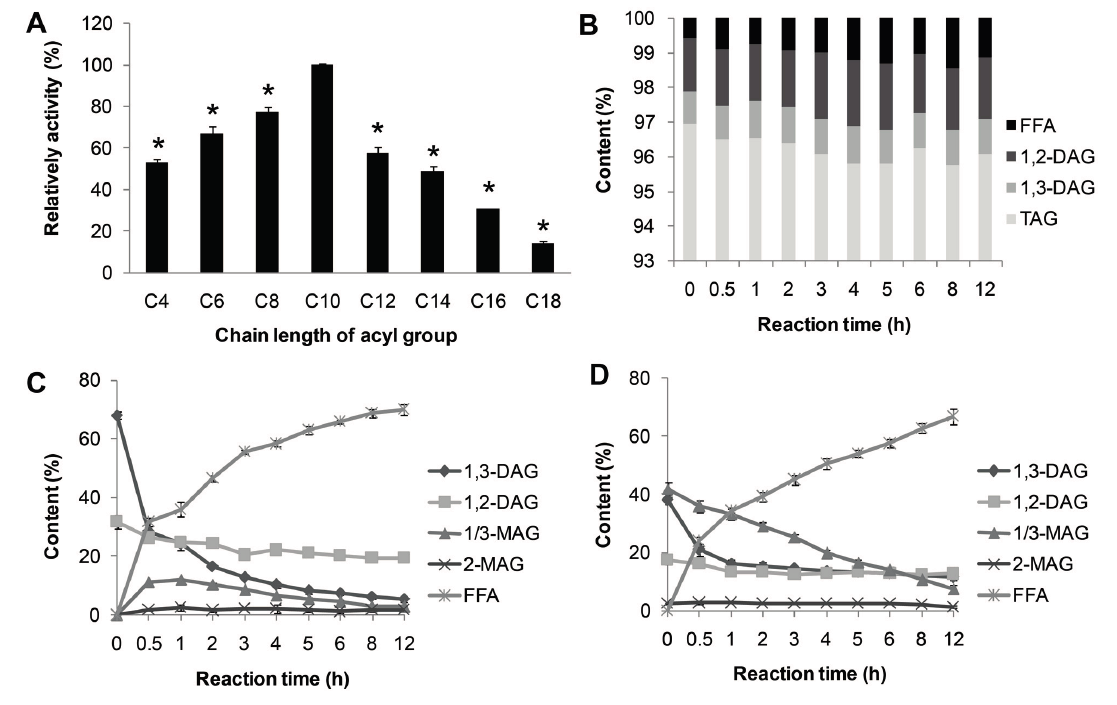
Figure 4. Substrate specificity of MAJ1. ( A ) Substrate specificity of MAJ1 toward various p -nitrophenyl esters; * compared to the relative activity of C10, p < 0.01; ( B ) Chemical composition (%) of fractions during hydrolysis of triacylglycerol (TAG)-enriched camellia oil; ( C ) Chemical composition (%) of fractions during hydrolysis of diacylglycerol (DAG)-enriched oil; and ( D ) Chemical composition (%) of fractions during hydrolysis of DAG: monoacylglycerol (MAG) (1:1)-enriched